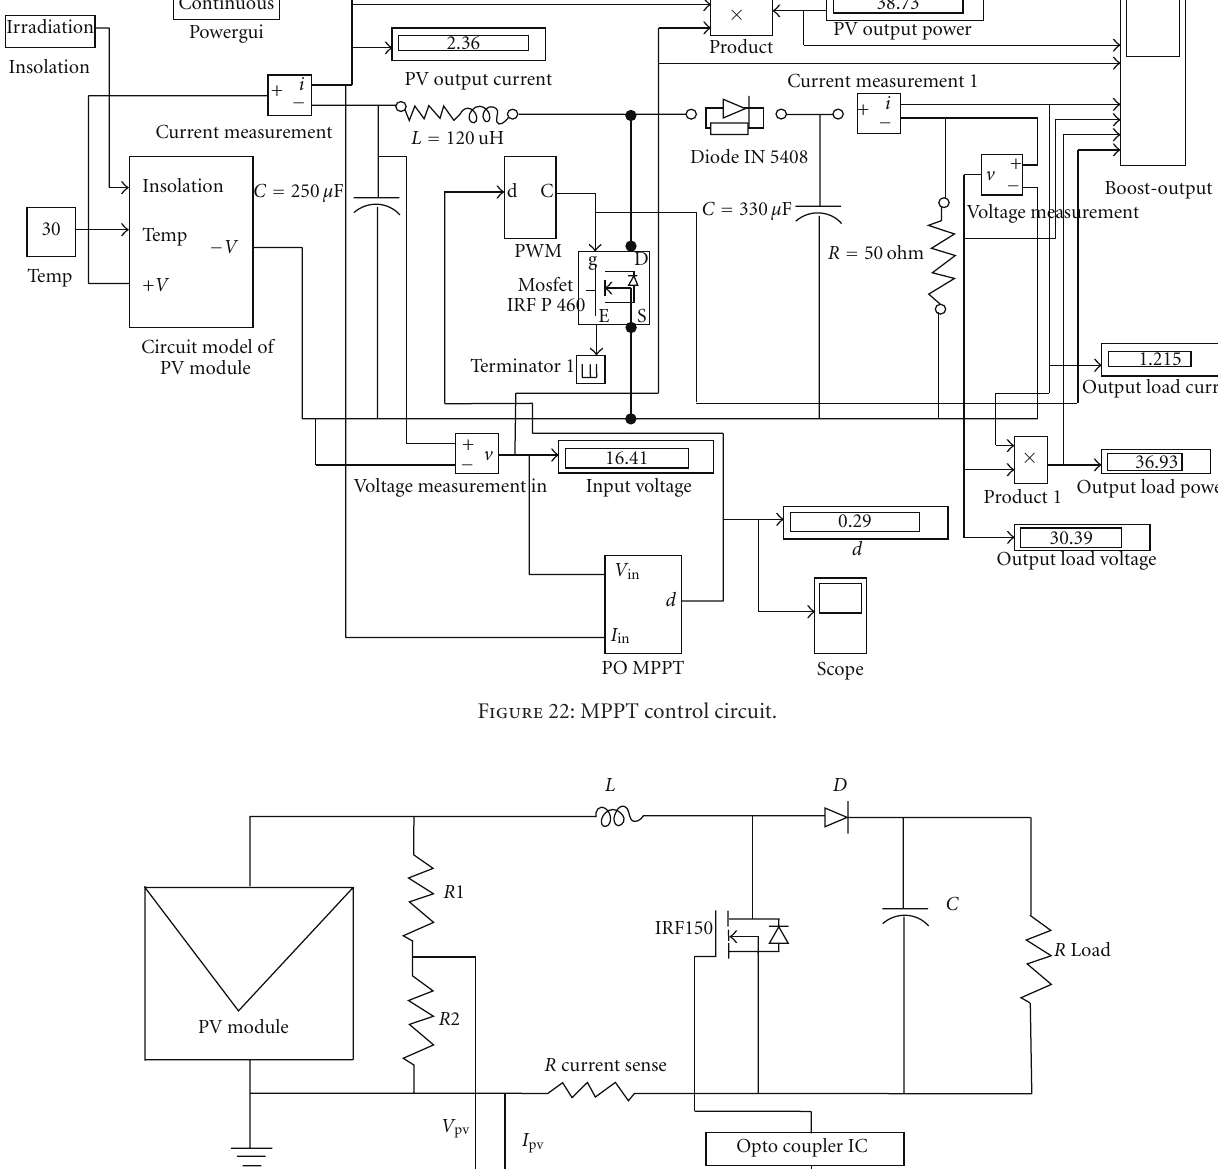
Figure 23: Proposed hardware